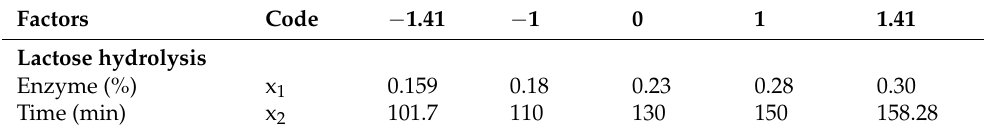
Table 1. Codified variables with variation levels for the hydrolysis of whey protein concentrate.